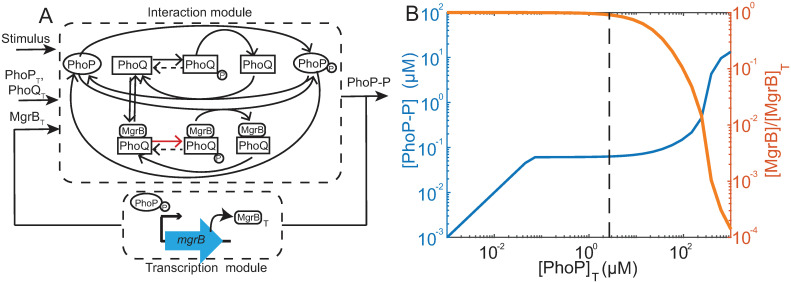
PhoP-P is robust to overexpression of PhoP, PhoQ.A—Modified PhoPQ TCS interaction network shows PhoQ binding MgrB, repressing PhoQ autophosphorylation (red arrow marks suppressed rate compared to unbound PhoQ autophosphorylation). This forms the interaction module. The interaction module takes 3 inputs (i) Stimulus (autophosphorylation rate), (ii) Total PhoP (PhoQ is assumed proportional, and 1/40 times PhoP based on actual measurements) and (iii) Total MgrB. Total protein is represented by subscript T in all figures and text. The system is numerically solved for a steady state concentration of PhoP-P as a function of varying PhoP, PhoQ total. The interaction module is coupled with a transcription module representing negative feedback with PhoP-P as input and total MgrB concentration as output. B—The system is solved numerically for steady state concentration of PhoP-P as a function of varying PhoP (and PhoQ) total (blue). PhoP-P is robust to PhoP/PhoQ concentrations, increasing further when PhoQ concentration is large enough to overcome MgrB negative feedback. Over most of the range of PhoQ concentrations, MgrB ≈ MgrB-total indicating large stoichiometric excess MgrB (orange line). Robustness breaks when MgrB is no longer in large excess of PhoQ. Dashed line indicates PhoP concentration estimated from measurements of Ref. [25].